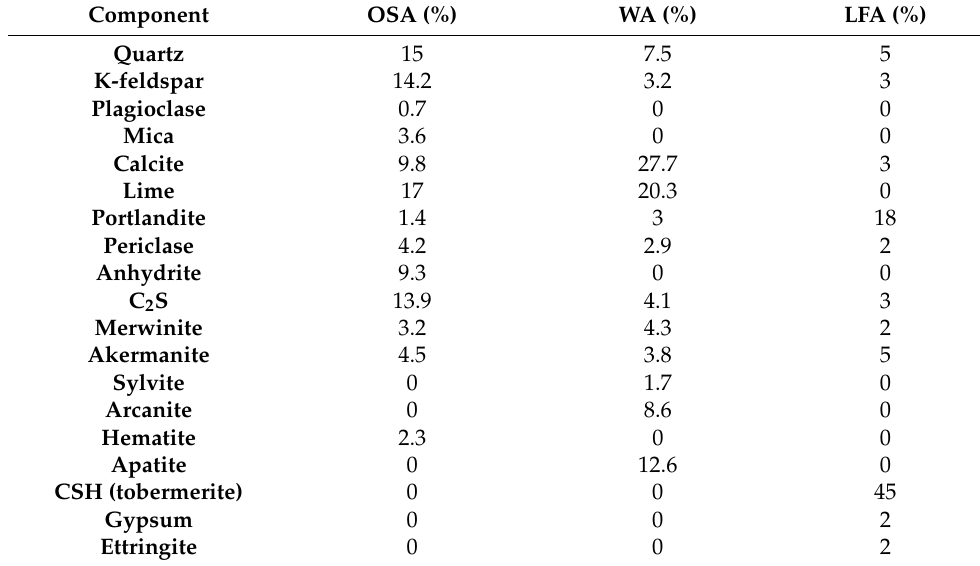
Table 2. Phase composition of OSA, WA, and